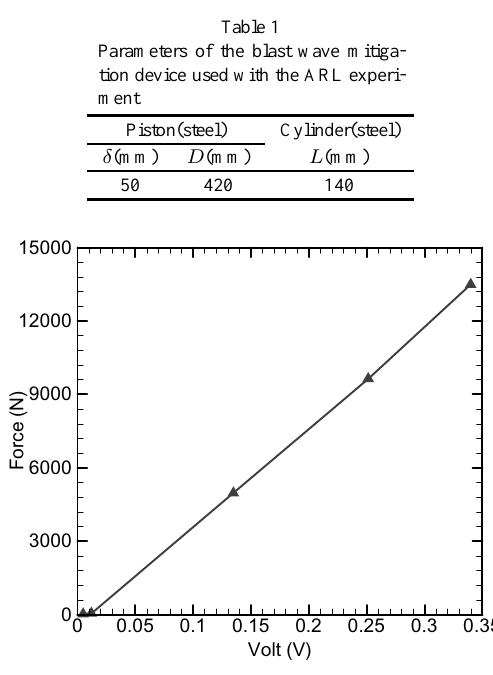
Fig. 7. Hopkinson bar force versus electrical